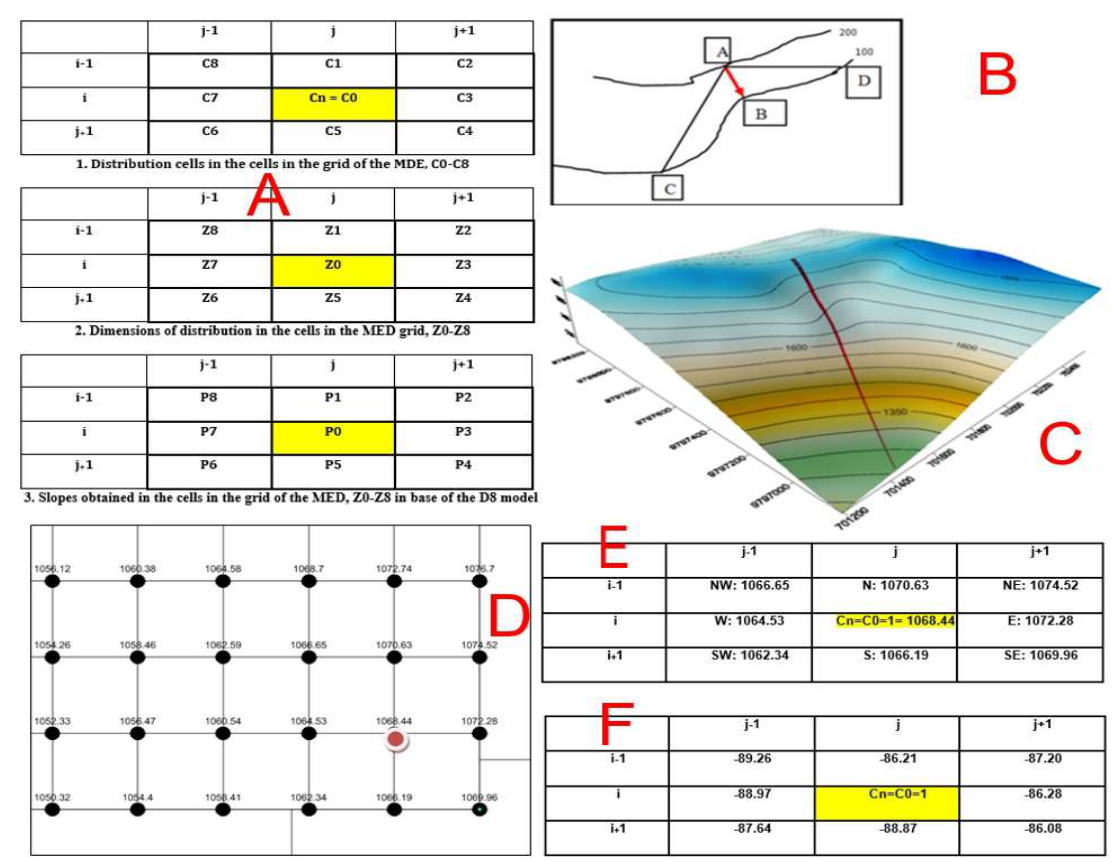
Figure 3. ( A ) Assignment of cells (C0–C8) and heights of the terrain (Z0–Z8) for the calculation of slopes (P0–P8) according to Model D8. ( B ) Determination of the Maximum Pending Line AB. Point A is the starting point on the 200 m level curve. Points B, C, and D define segments AB, AC, and AD, respectively. The line of the maximum slope corresponds to the shortest AB segment, which is generally the route through which water flows from the highest point A. ( C ) Tracing of the maximum-slope line in a digital elevation model and tracing of the maximum-slope line in a digital elevation model (DEM). ( D ) Initial point of the line at time t = 0, with initial state C0 = 1, and dimension assigned by the DEM = 1068.44. ( E ) Initial cell at the elevation of 1068.44 meter above sea level (masl) for the generation of flow lines of meteoric water-surface runoff according to the D8 Model and ( F ) final score.